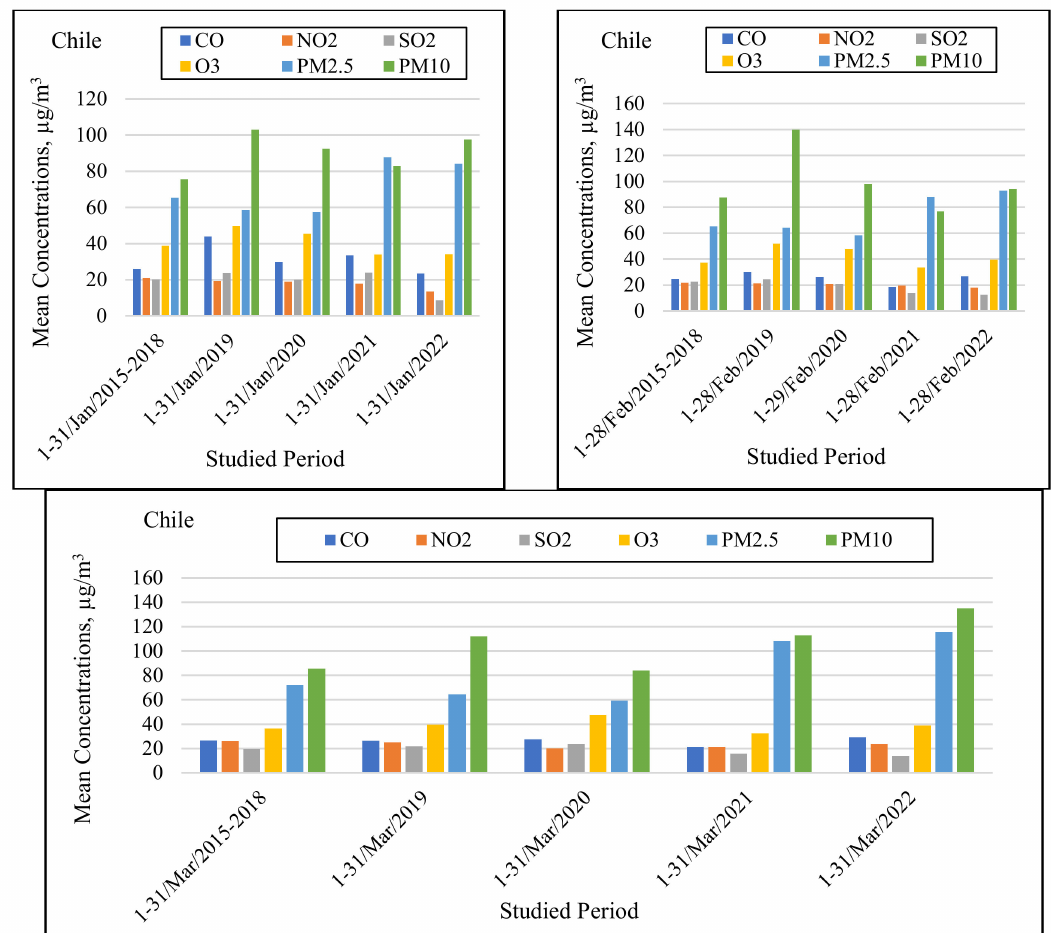
Figure 3. Average concentrations of air pollutant in countries of the South